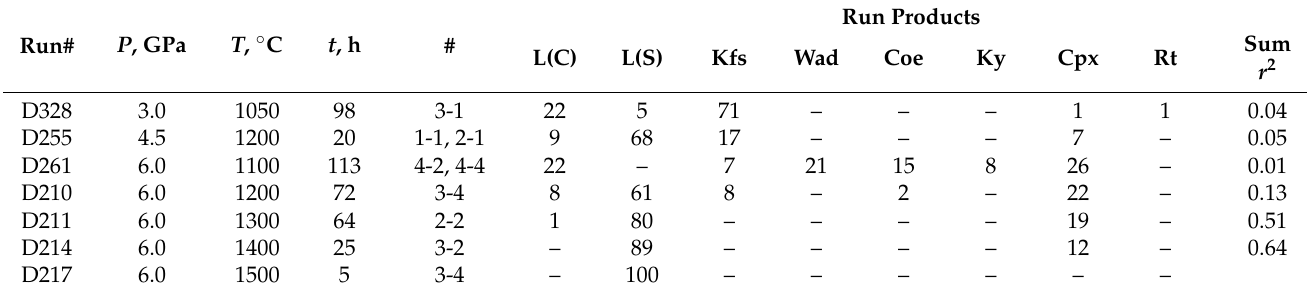
Table 3. Summary of run conditions and calculated phase proportions (mol%) in the system L(S).